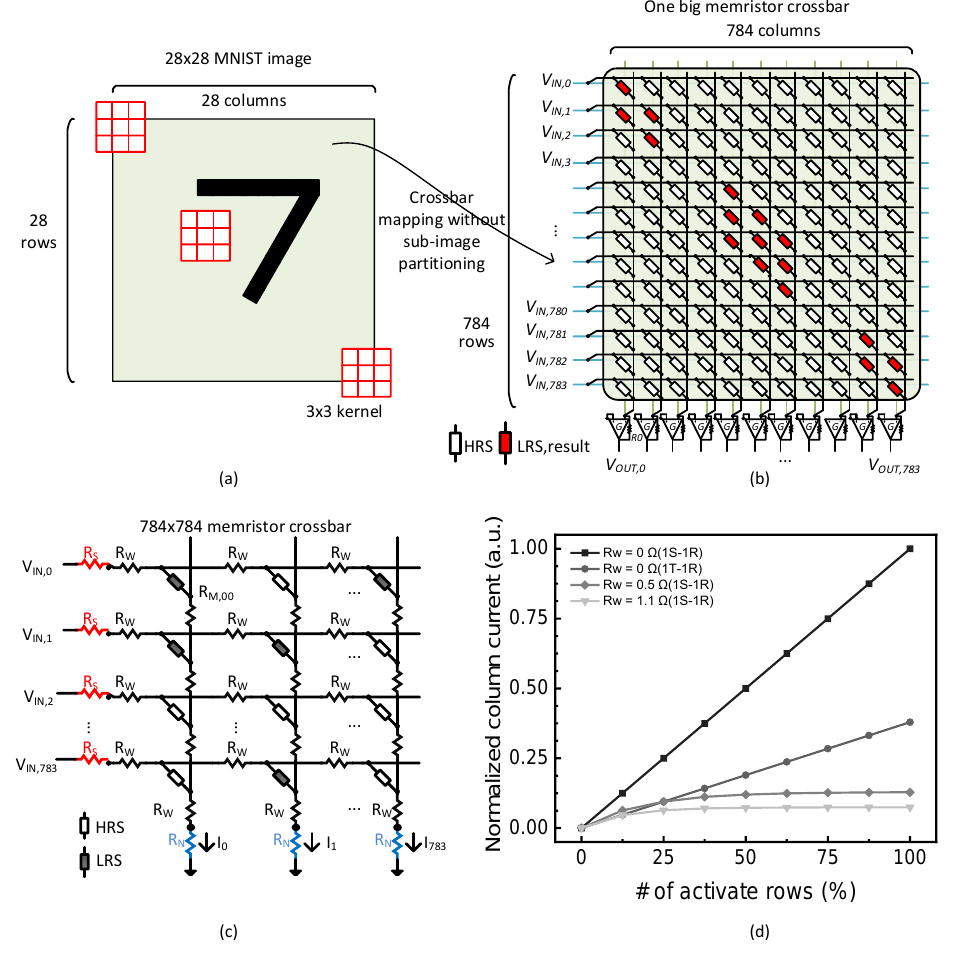
Figure 2. ( a ) The convolution of 28 × 28 MNIST image with 3 × 3 kernel without using the sub-image partitioning. ( b ) The memristor crossbar for the full-image convolution without using the sub-image partitioning. ( c ) The crossbar circuit with parasitic resistance such as source, line, and neuron re- sistance. ( d ) The normalized column current with increasing the number of active rows (%), for 1S- 1R and 1T-1R cells. Here, R W means line resistance per cell and the crossbar’s column has 784 cells per column. When R W = 0.5 Ω and R W = 1.1 Ω, the normalized column currents seem to saturate rapidly with increasing the percentage active rows over 25%. It means the MAC calculation accuracy is degraded very much when R W is not zero. For overcoming the large line resistance problem due to large-size crossbars, the MNIST image should be partitioned into several sub-images. For example, the 28 × 28 MNIST image can be divided into sixteen 7 × 7 sub-images, as indicated in Figure 3a. Here, each 7 × 7 sub-image convolution can be mapped to memristor crossbars with much smaller size than 784 × 784, as shown in Figure 3b. As explained earlier, the number of crossbar’s rows is the same with the number of input pixels involved in the convolution. Similarly, the number of crossbar’s columns is equal to the number of output pixels cal- culated from the convolution. By doing so, the crossb ar’s row and column numbers for 7 × 7 sub-image convolution can be calculated with 81(=9 × 9) and 49(=7 × 7), respectively, as shown in Figure 3b.